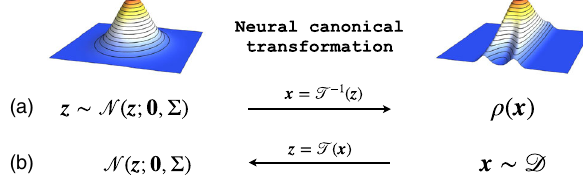
FIG. 1. A neural canonical transformation maps between the latent variables z and physical variables x via a symplectic neural network. The transformation preserves the Hamiltonian equation and connects the phase-space trajectories in the physical and the latent spaces. There are two ways to train the neural canonical transformation: (a) variational free energy based on the Hamil- tonian [Eq. (5)]. (b) density of phase-space estimation based on data [Eq.